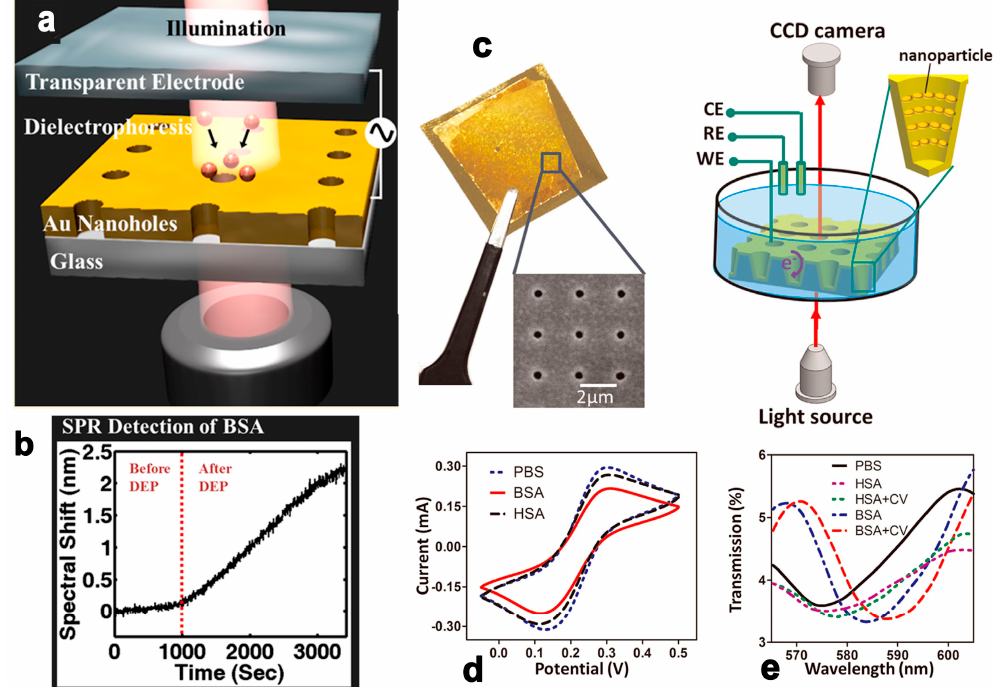
Figure 5. Schematic of the experimental setup for dielectrophoretic concentration of analyte molecules ( a ) and spectral shift of BSA’s SPR detection ( b ). Reprinted with permission from [47]. Copyright (2014) ACS; The nanoCA for electrochemical and LSPR measurement ( c ) and Transmission spectrum ( d ) of nanoCA with PBS, 100 μ g/mL HSA and HSA plus CV scanning, 100 μ g/mL BSA and BSA plus synchronous CV scanning and statistic ( e ) for shifts in dip wavelength of HSA, HSA plus CV, BSA and BSA plus CV. Reprinted with permission from [49]. Copyright (2015) Elsevier.